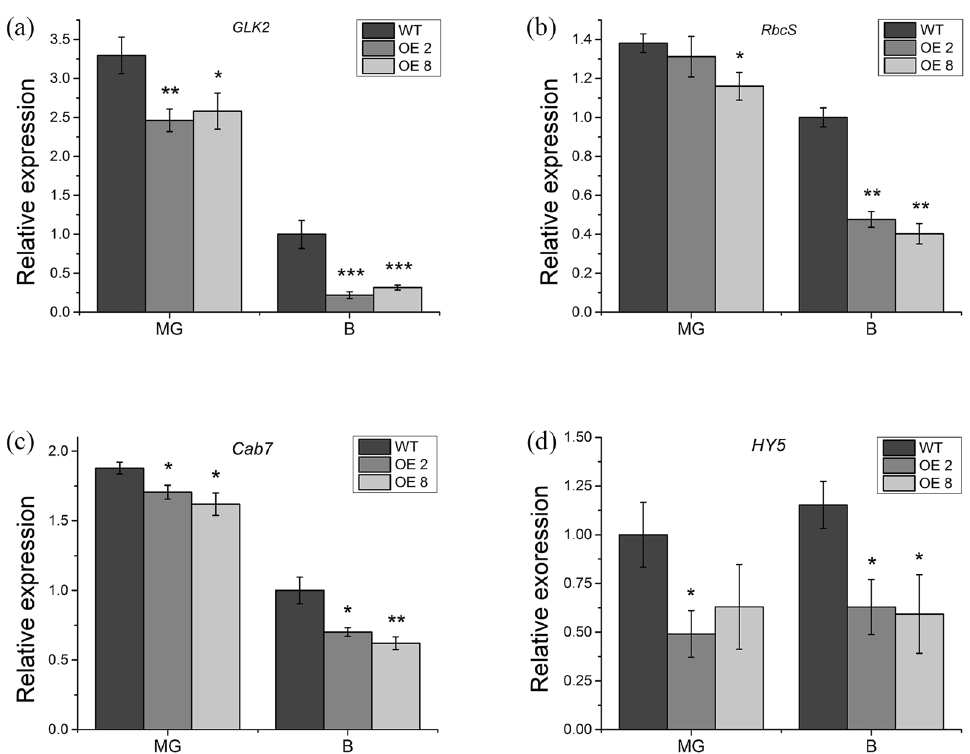
Figure 7. Chlorophyll metabolism related genes expression in wild type and 35 S:PRE2 lines. ( a ) to ( d ) respectively represent expression levels of GLK2 , RbcS, Cab7 , and HY5 in different stage fruits of wild type and 35 S:PRE2 lines. MG, mature fruit; B, breaker fruit. Data are the mean ± SD of three biological replicates. * Significantly different from the wild type, P < 0.05; ** for P <